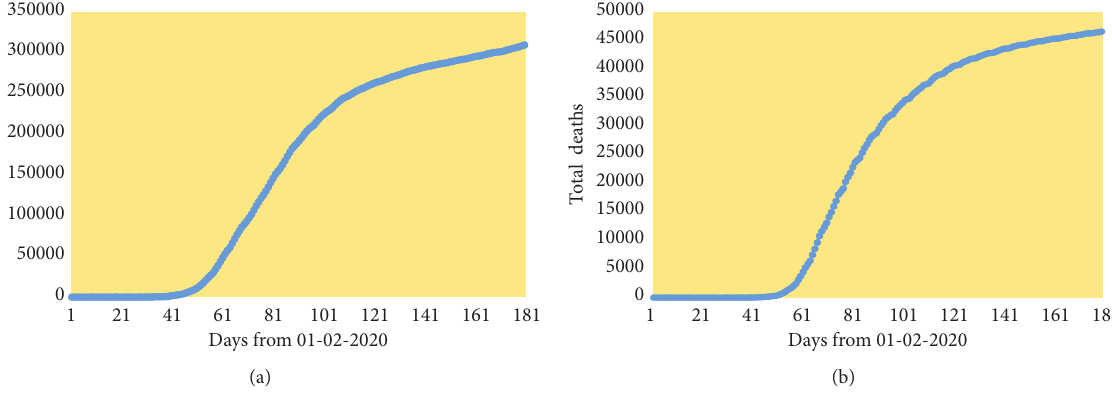
Figure 2: (a) Trends in total cases, UK; (b) trends in total deaths, UK.